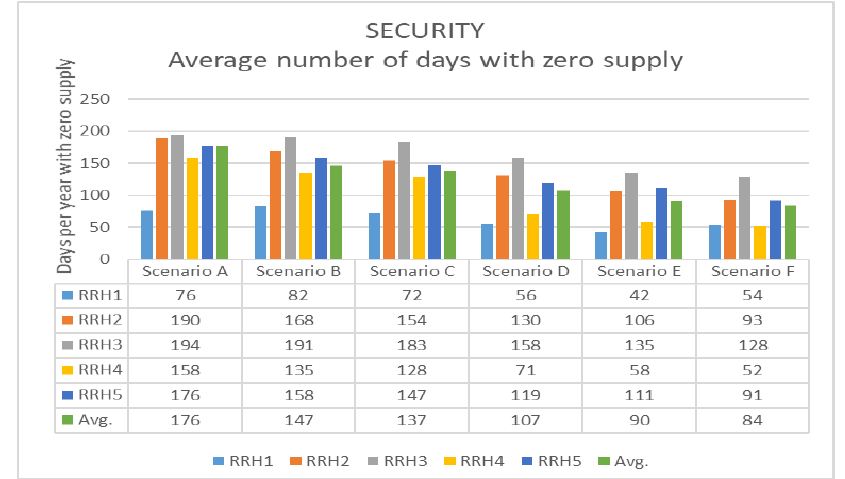
Figure 9. Comparison of RRHS modelling results — Security of supply.